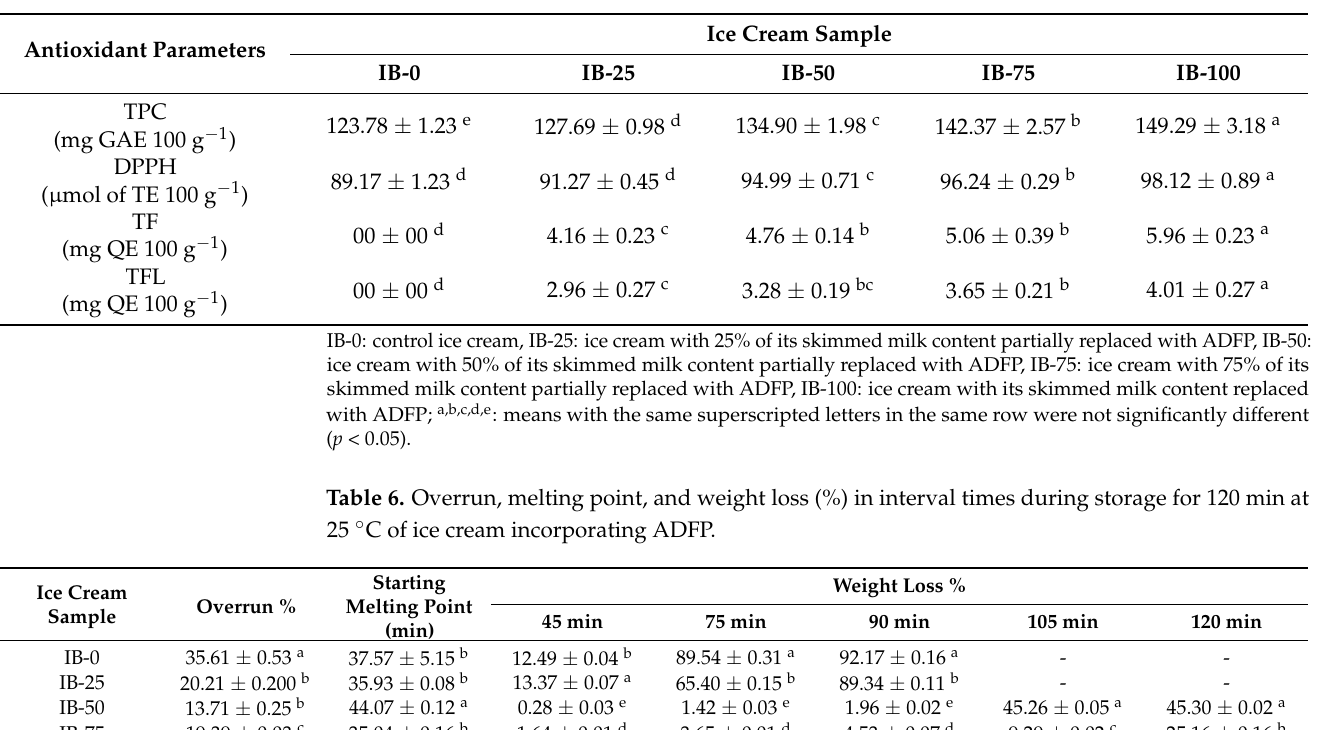
Table 5. Total phenolic content, antioxidant activity total, flavonoids (TF), and total flavanols (TFL) in ice cream incorporating ADFP.